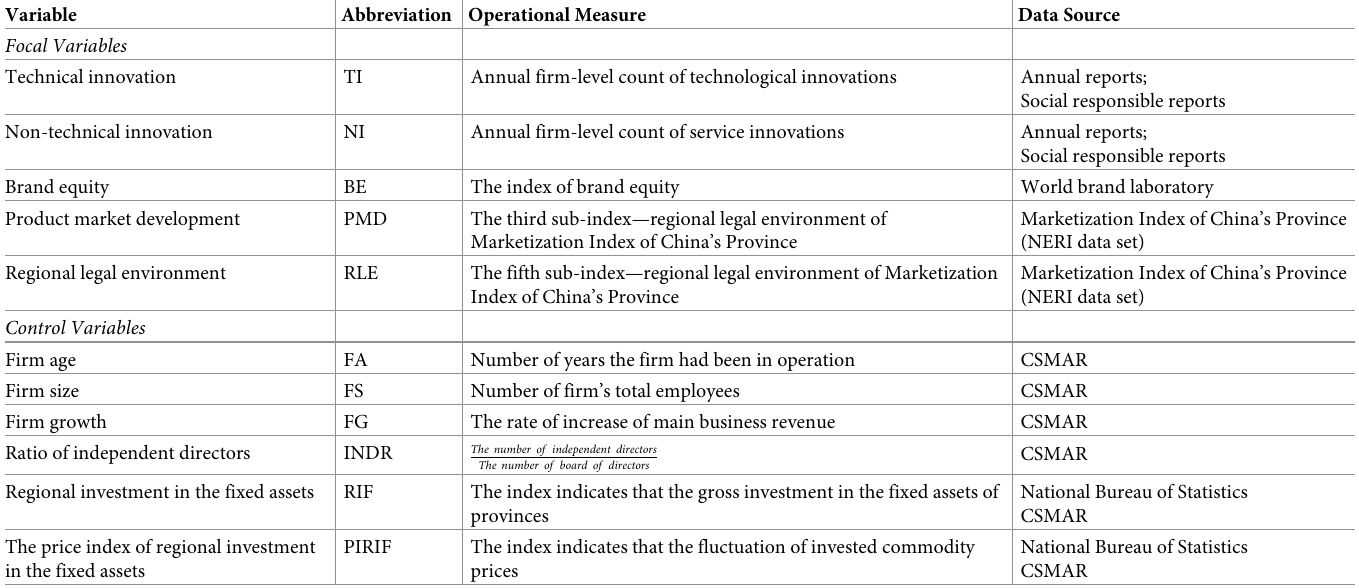
Table 1. Variables, measures, and data